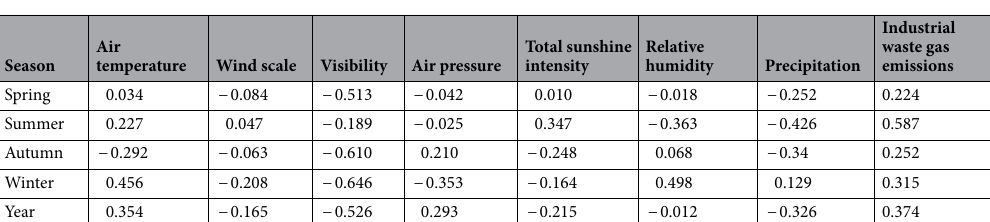
Table 2. Correlation between seasonal and annual AQI and meteorological elements from 2017 to